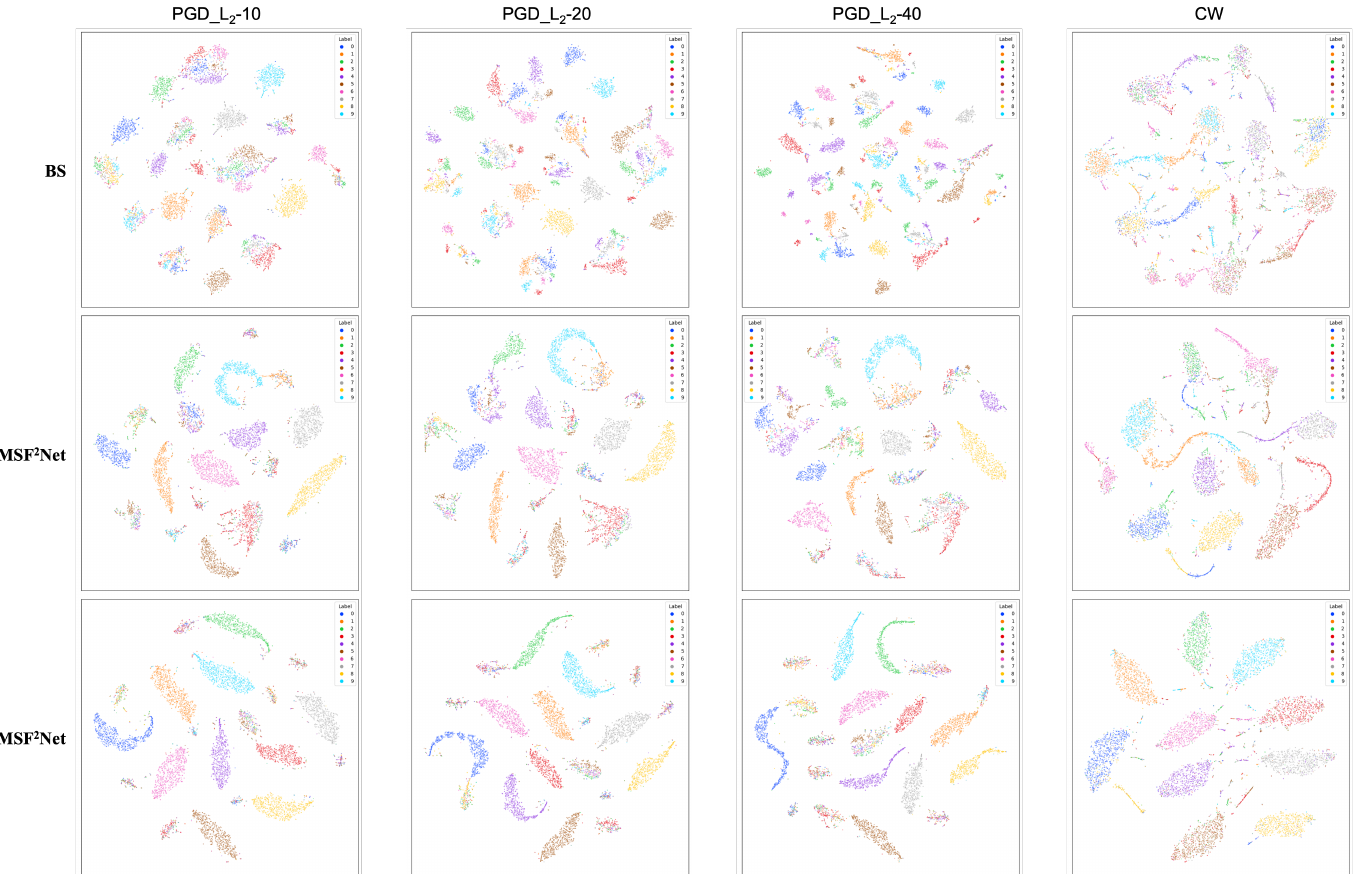
Figure 11. t-SNE visualization results of the baseline, MSF 2 Net, and EMSF 2 Net under the L 2 -norm attacks on the CIFAR-10